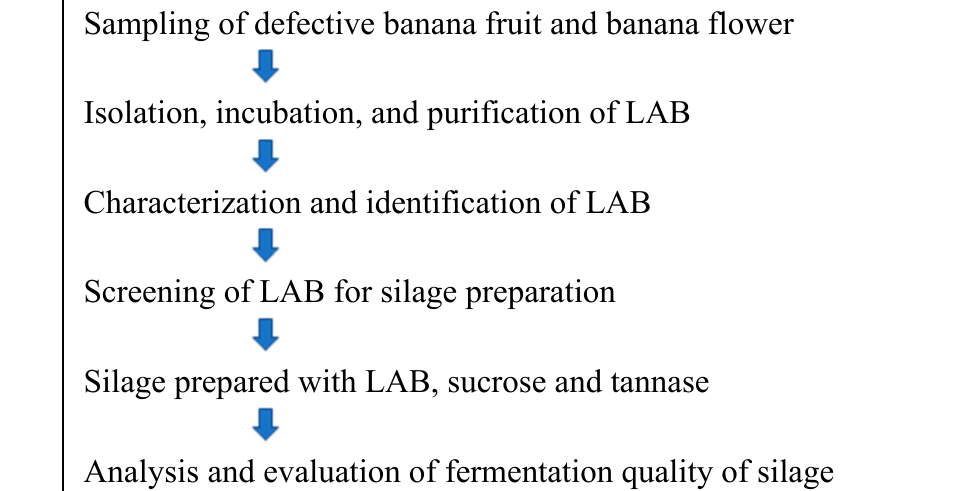
Figure 1. Experimental flow chart of this study.